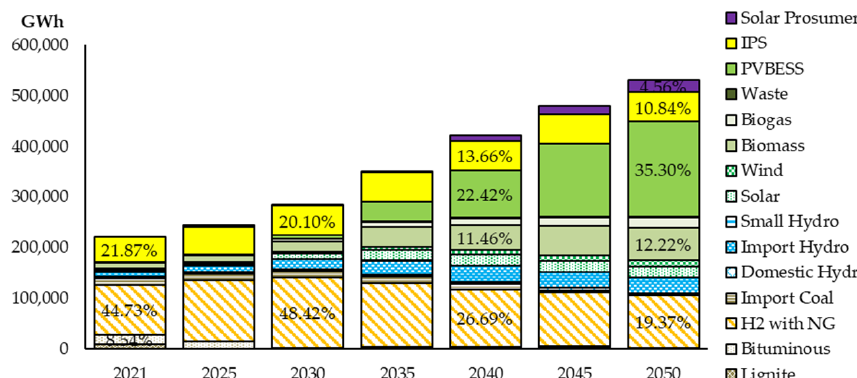
Figure 17. Fuel mix ratio of the 50% hydrogen scenario.